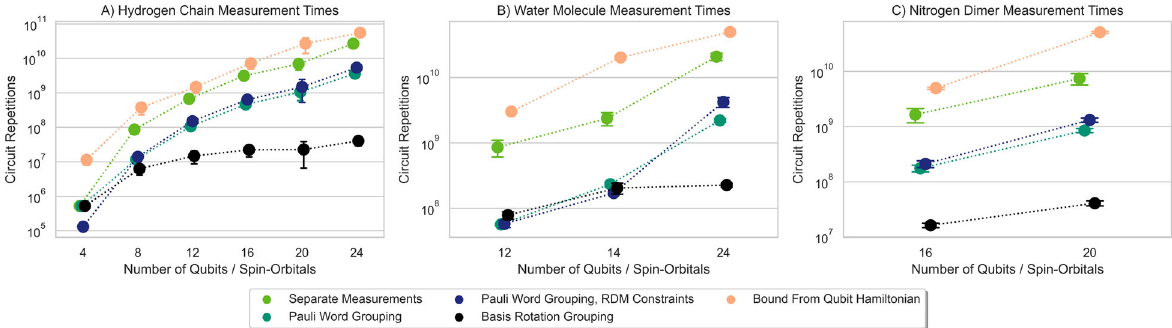
Fig. 1 The number of circuit repetitions required to estimate the ground state energy of various systems using fi ve different measurement strategies. The number of circuit repetitions required to estimate the ground state energy of various systems. From left to right: A hydrogen chains of varying lengths in varying basis sets, B a water molecules in varying basis sets, C a nitrogen dimer in varying basis sets. The speci fi c systems considered are enumerated in Table 2. A target precision corresponding to a 2 σ error bar of 1.0millihartree is assumed. Calculations performed on systems that require the same number of qubits (spin orbitals) are plotted together in columns. The cost of our proposed measurement strategy appears to have a lower asymptotic scaling than any other method we consider and obtains a speedup of more than an order of magnitude compared to the next best approach for a number of